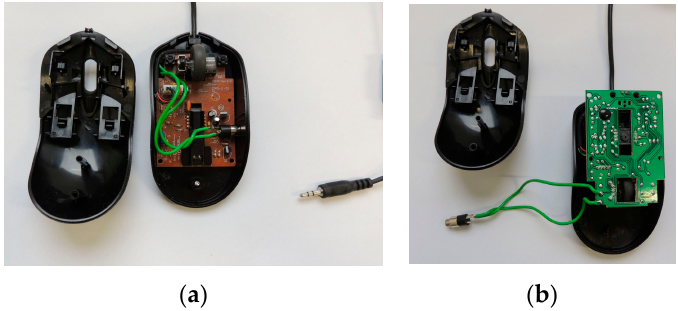
Figure 9. Modified computer mouse with extra connection to the left mouse button – extra socket built in ( a ) and simple soldered connection to the button ( b ).